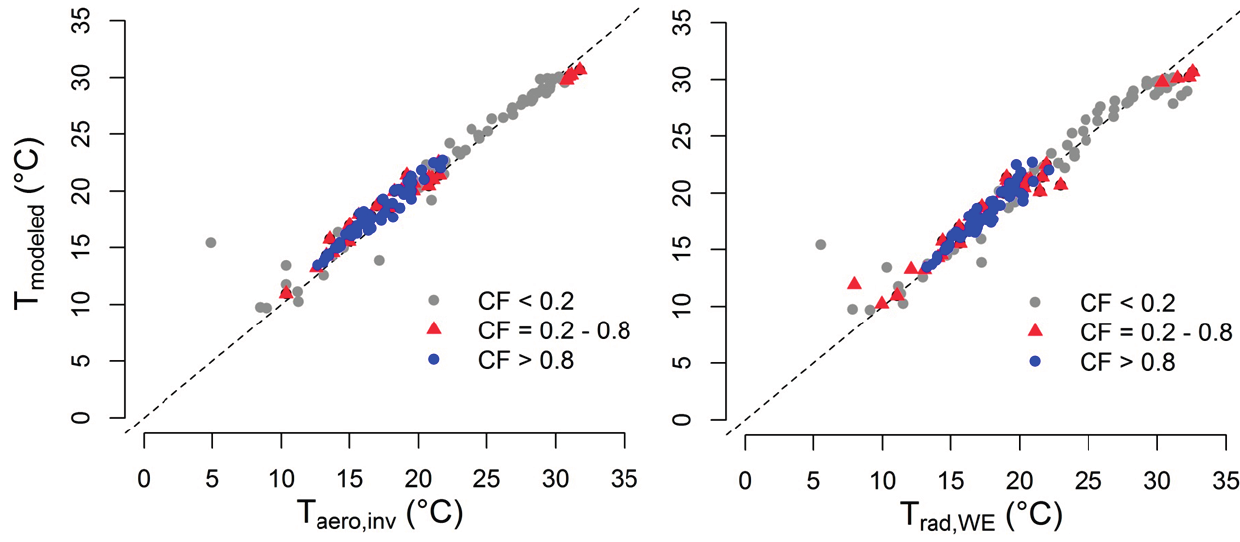
, modeled ), as well as the aero,inv ). CF = cloud rad,WE